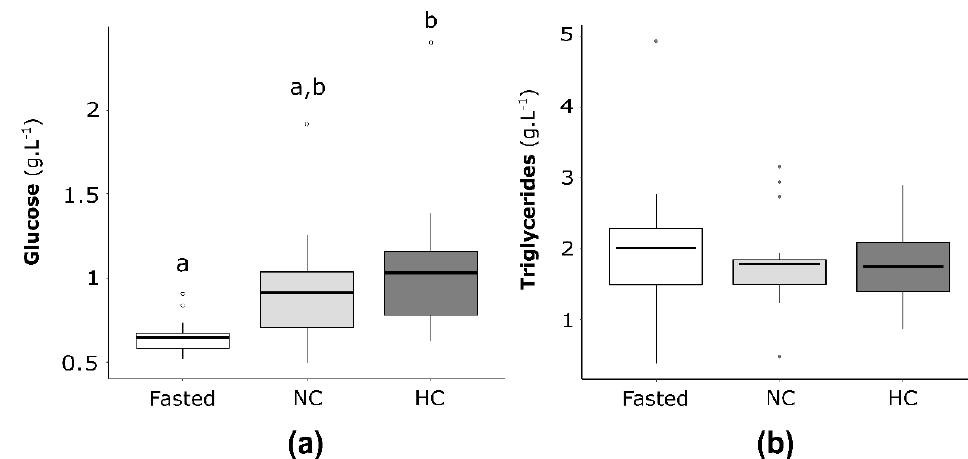
Figure 6. ( a ) Plasma glucose and ( b ) triglycerides concentrations of neomale rainbow trout fasted for 15 days (Fasted, white), fed with the NC diet (non-carbohydrate diet, grey) and fed with the HC diet (high-carbohydrate diet, dark grey). Data ( n = 15 fish per condition) were analysed with either one-way ANOVA when the conditions of application were respected, or the Kruskal-Wallis test, followed by a post hoc Tukey’s test in case of significant differences ( p < 0.05, indicated with different letters).